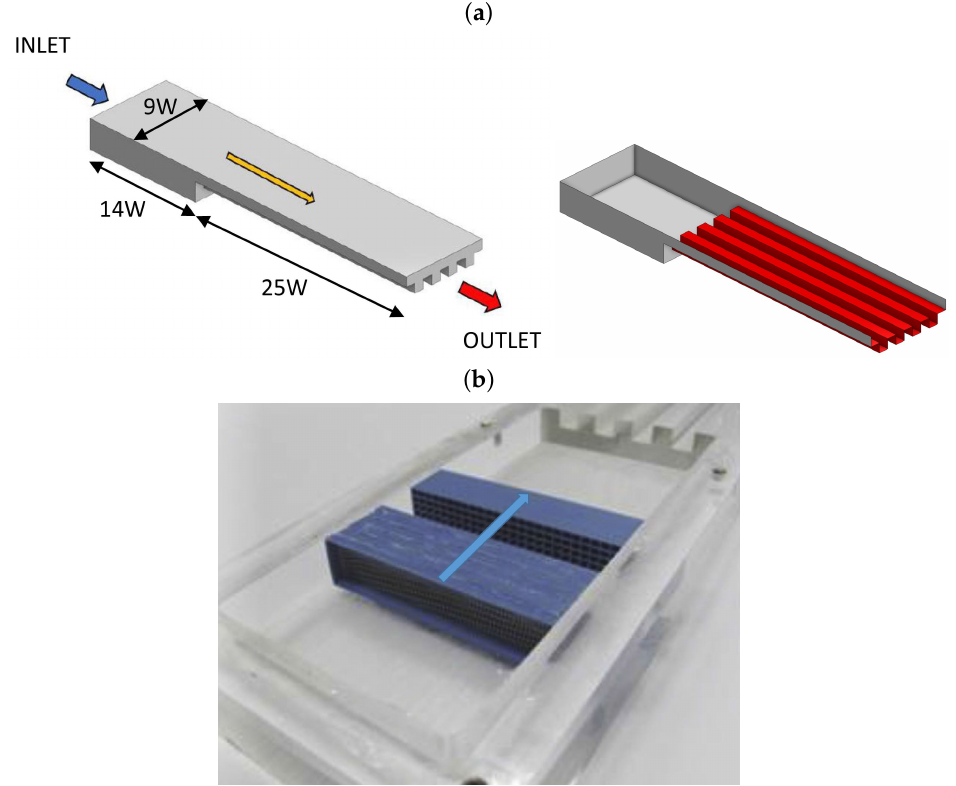
Figure 1. ( a ) Sketch of the domains dimensions and detail of the heated (red color) fin walls. ( b ) View of the experimental prototype (lid was retired for the picture), of dimension W = 10 mm, used to validate the numerical